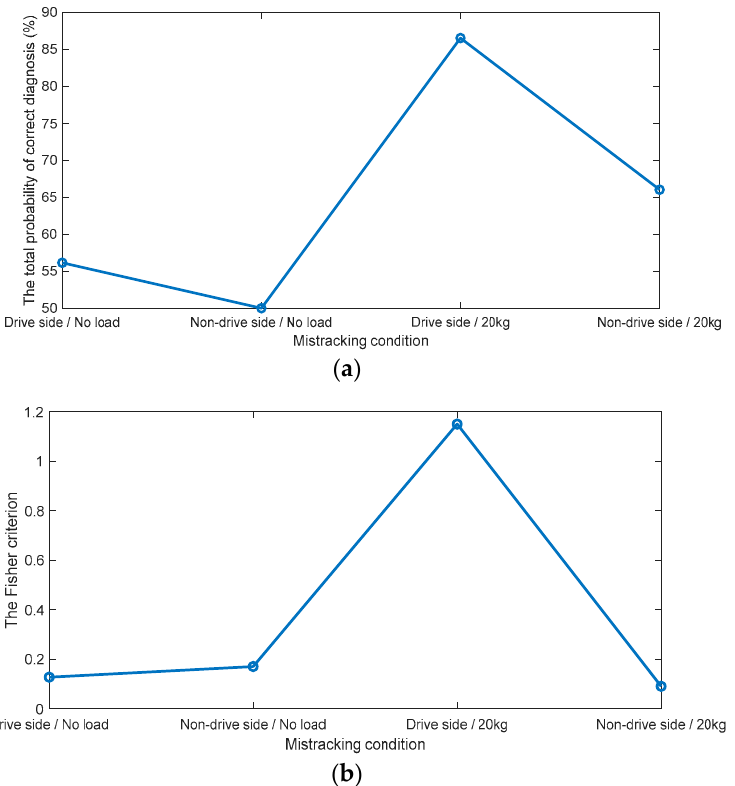
Figure 8. ( a ) The total probabilities of correct diagnosis (%), provided by the bicoherence ( b ) The Fisher criteria for the bicoherence.